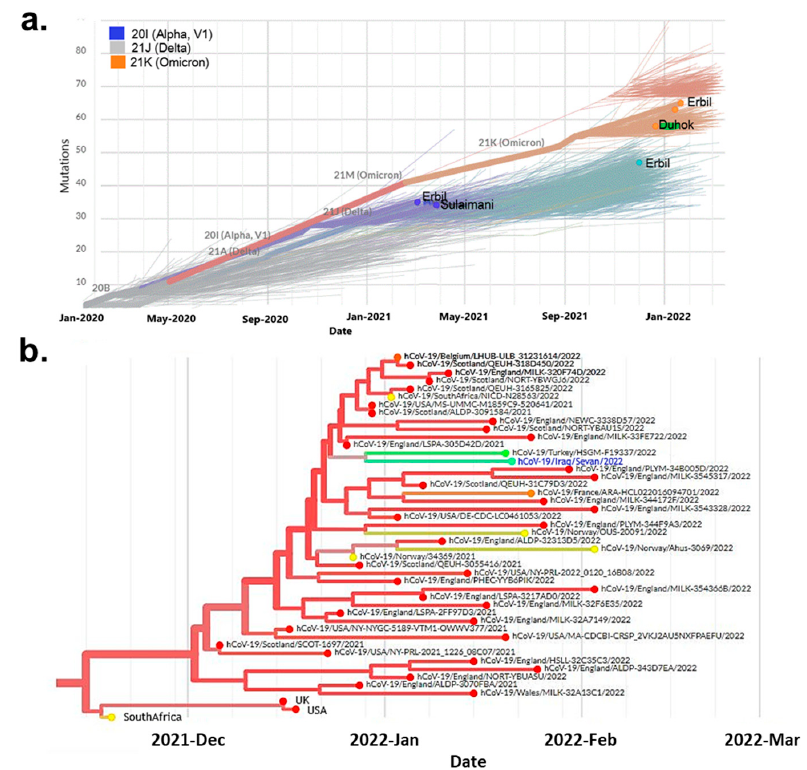
Figure 3. Maximum likelihood phylogenetic tree for the genomic sequences of SARS-CoV-2 variants recorded in Iraqi Kurdistan governates. ( a ) Analysis of eight genomic sequences recorded in